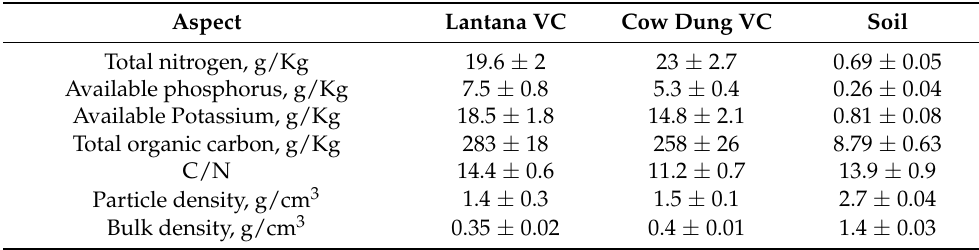
Table 1. Composition of the soil and the vermicomposts deployed in the present study.